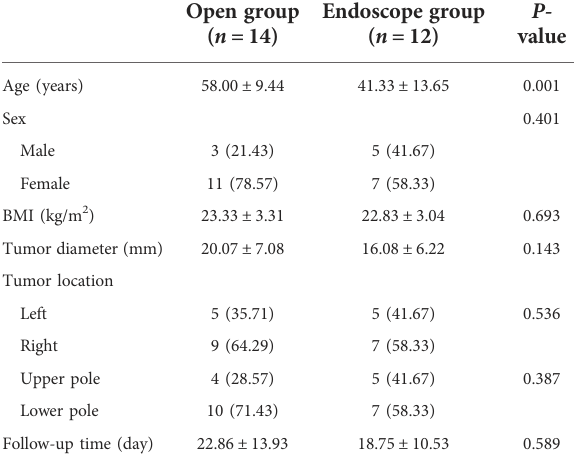
TABLE 1 Characteristics of patients and tumor baseline in two